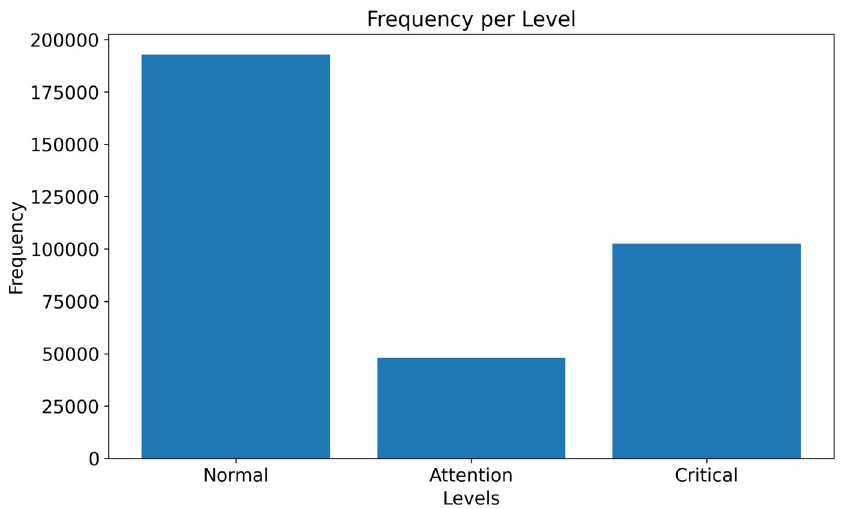
Fig 1. Histogram of the duration of the decision of the processes.